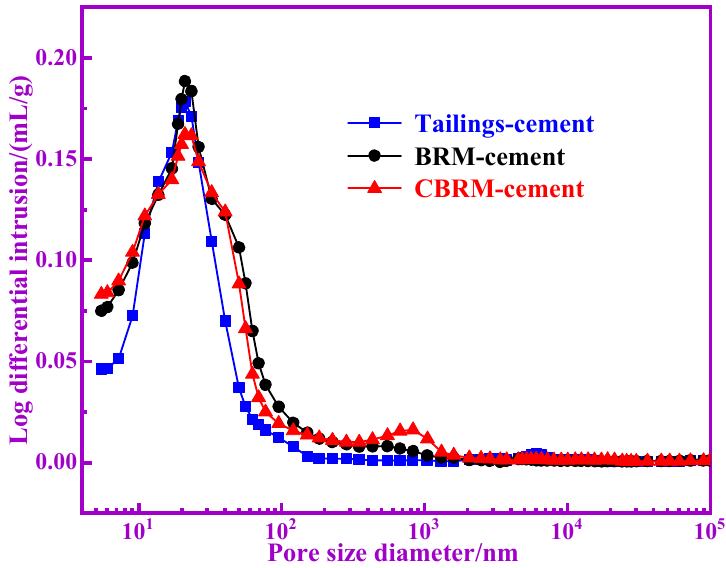
Figure 10. The curves of log differential invasion of BRM-cement, CBRM-cement, and Tailings-cement.